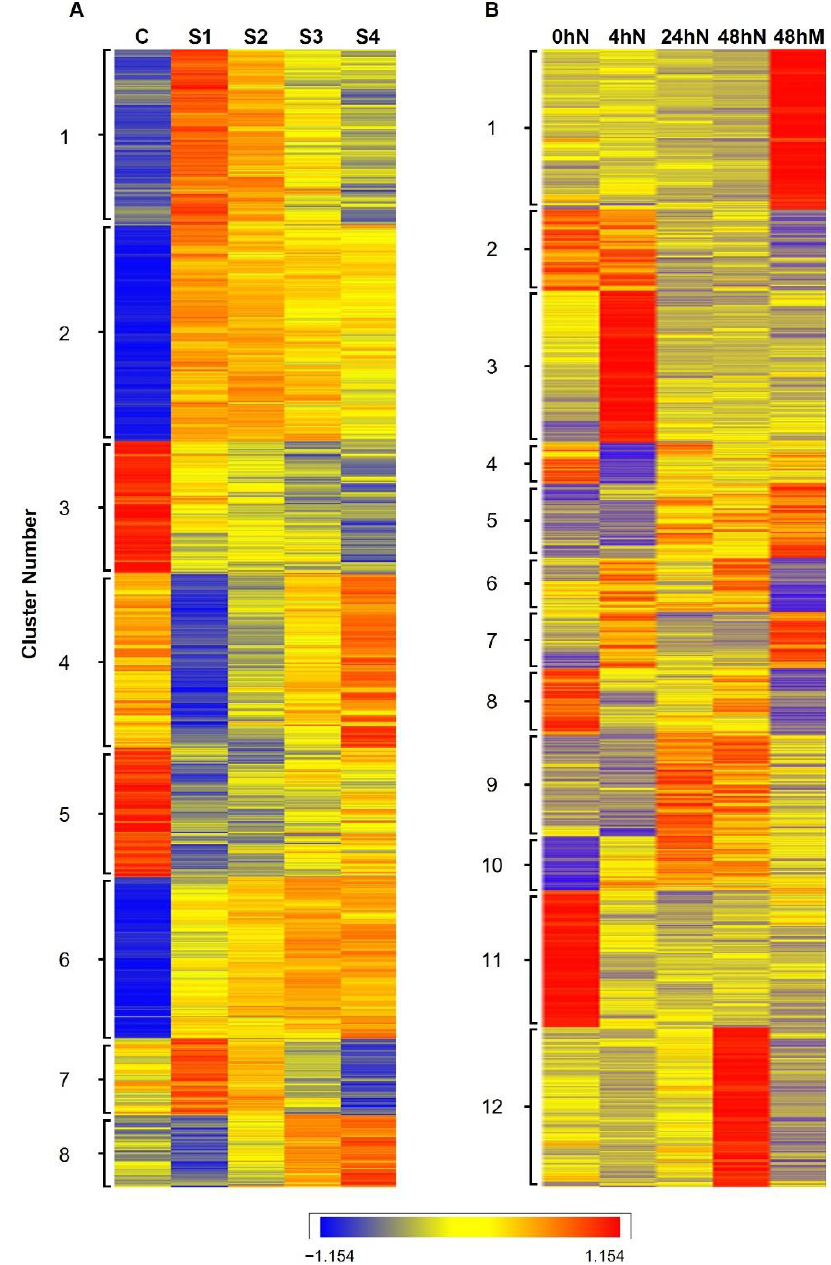
Figure 2. Heatmap shows hierarchical clustering of genes with similar expression profiles. ( A ) The heatmap shows a total of 4594 differentially expressed genes in K. daigremontiana , which are grouped into eight clusters with similar expression profiles. Only genes with adjusted p -value ≤ 0.05 and log2 fold-change > |0.6| were selected. C: Control; S1: Stage 1; S2: Stage 2; S3: Stage 3; S4: Stage 4. ( B ) The heatmap shows a total of 5706 differentially genes in K. pinnata , which are grouped into 12 clusters with similar expression profiles. Only genes with adjusted p -value ≤ 0.05 and log2 fold-change > |1.585| were selected. N: Leaf notches; M: Leaf mid-section. The color range of blue-ye-low-red indicates expression levels from low to high.